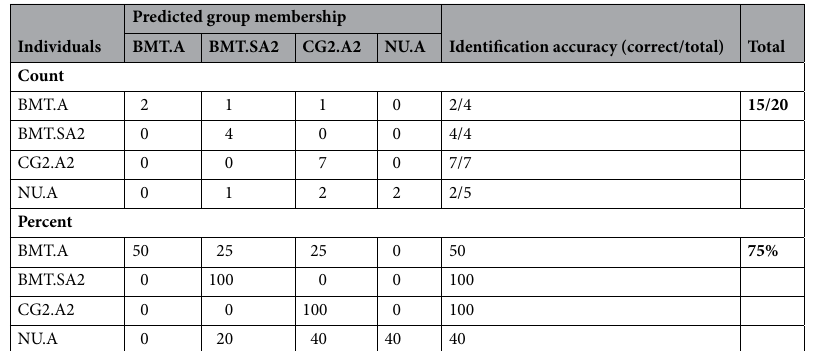
Table 4. Details of individual identification accuracy using hierarchical clustering on testing data (20 howls from four individual). 15 out of 20 howls were identified correctly with the accuracy of 75%.